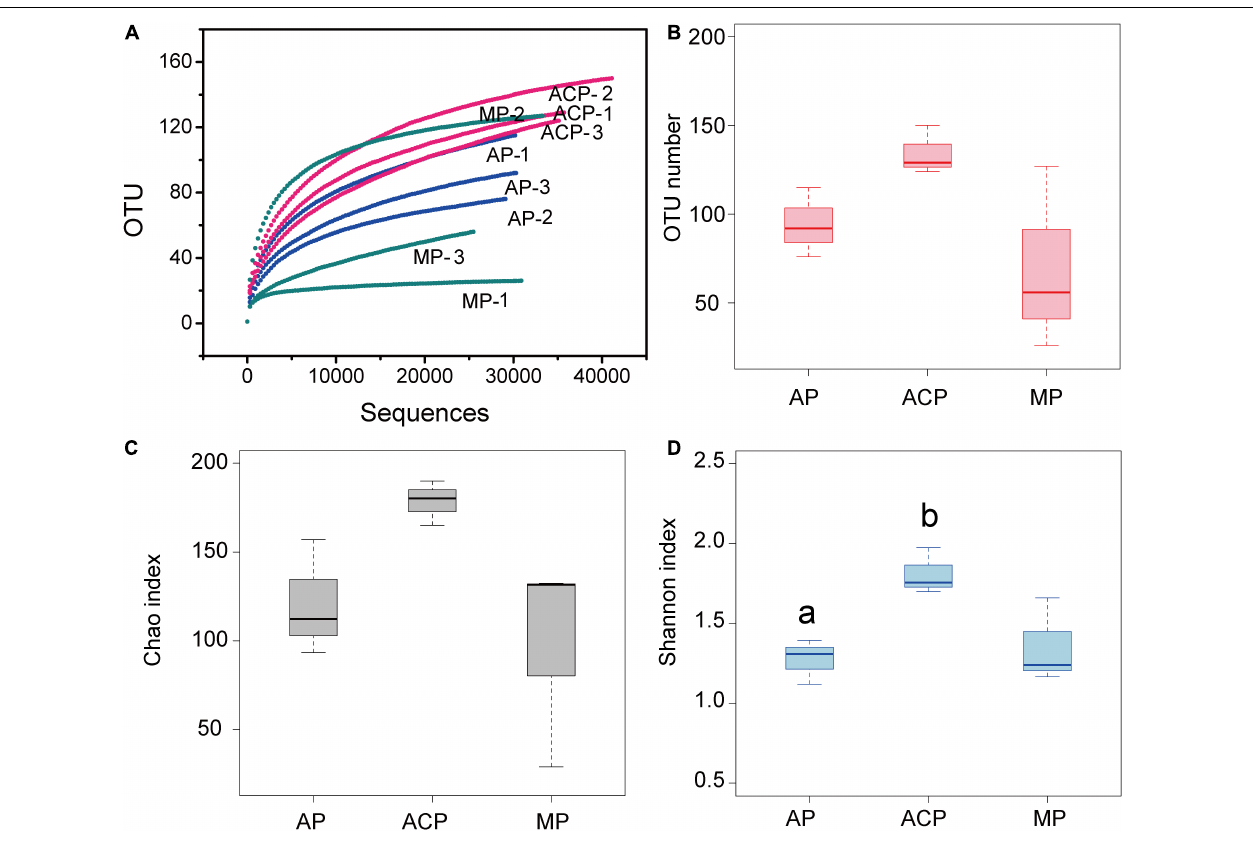
FIGURE 2 | Sequence rarefaction curve and archaeal diversity of solid waste samples. (A) Sequence rarefaction curve. (B) Observed OTU numbers. (C) Chao richness index. (D) Shannon diversity index. Each sample was determined in triplicate ( n = 3). Data were shown as average ± SD. AP: aerobic phase ( n = 3); ACP, anaerobic acid phase ( n = 3); MP, methanogenic phase ( n = 3). Values with different letters were significantly different ( p <